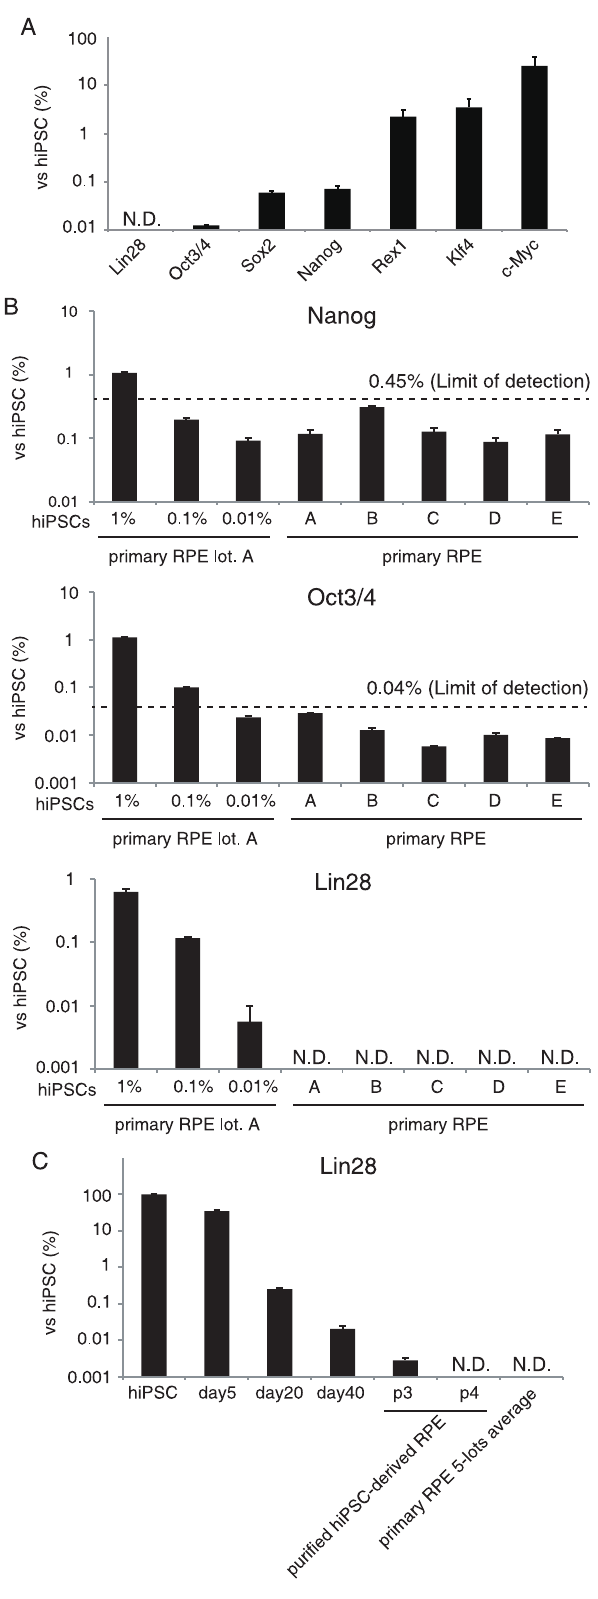
Figure 4. Detection of undifferentiated hiPSCs by qRT-PCR assay. (A) The relative mRNA expressions in primary RPE cells of Lin28, Oct-3/4, Sox2, Nanog, Rex1, Klf4, and c-Myc were determined by